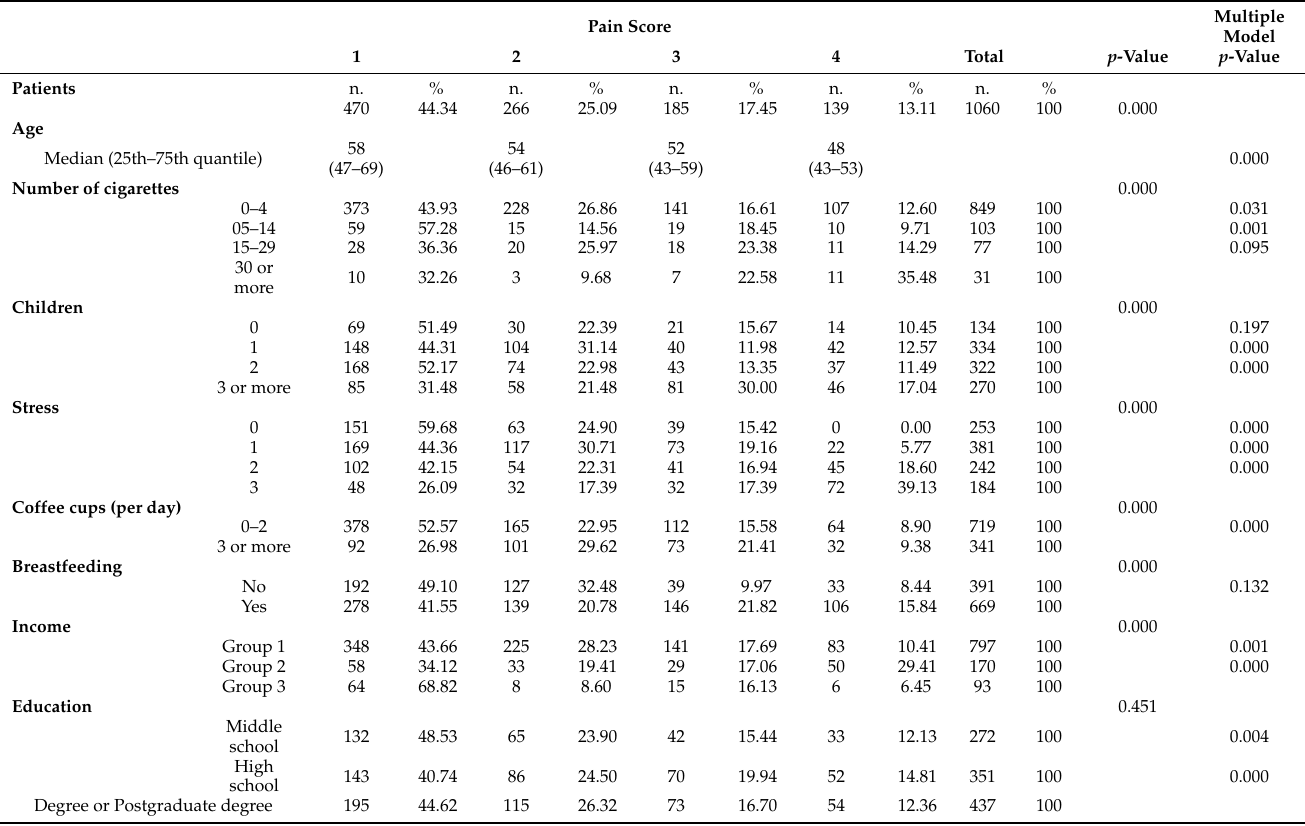
Table 2. Measured association between the pain score (from 1 to 4) and the variables age, coffee cups consumed per day, number of children, stress level, smoking habit, previous breast surgery, previous breastfeeding, the presence of benign disease, income level, education, breast density, previous benign pathology, and previous breast